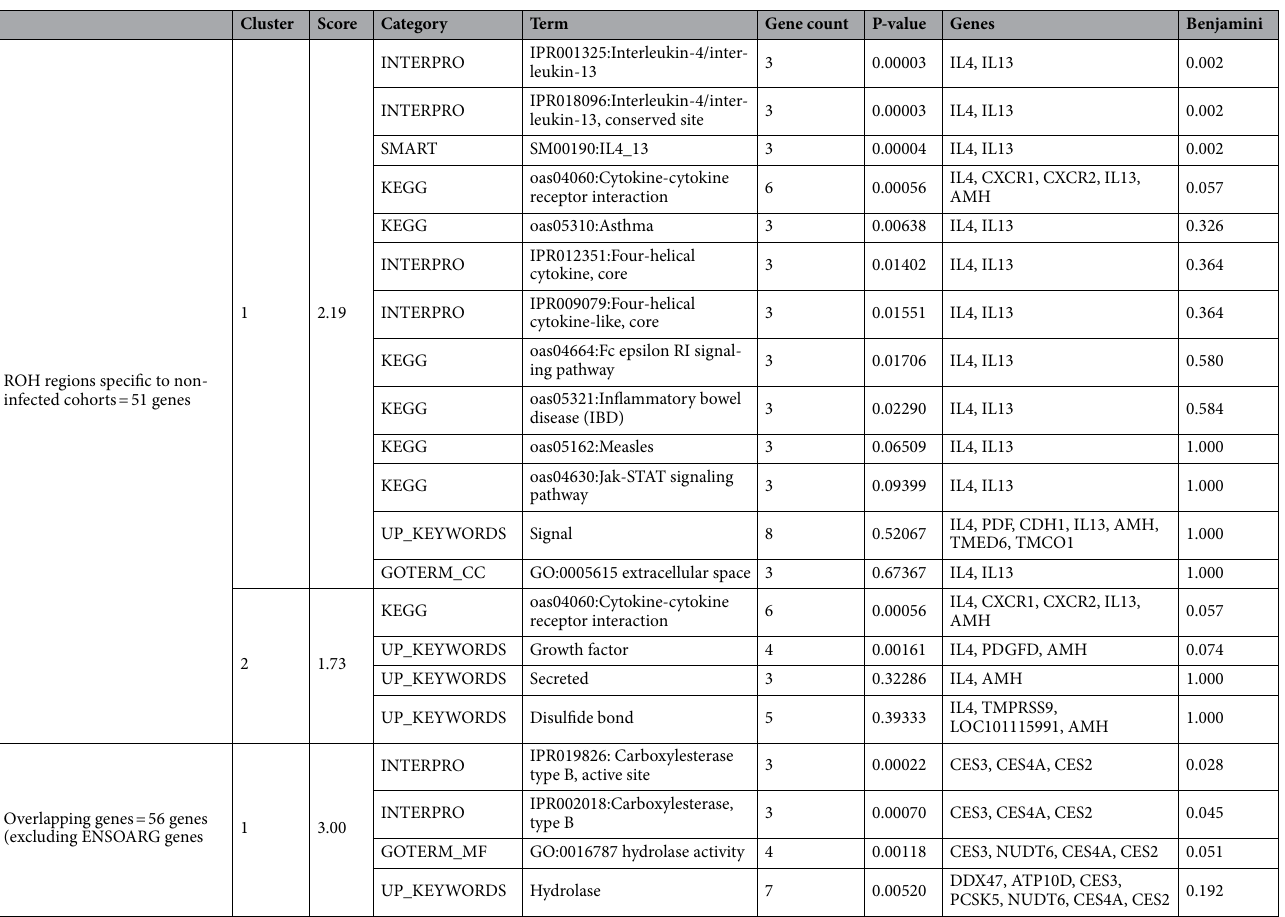
Table 5. Enriched functional term clusters following DAVID analysis of genes identified by ROH analysis in candidate regions that were specific to the non-infected cohort and those that overlapped between at least two methods of detecting selection